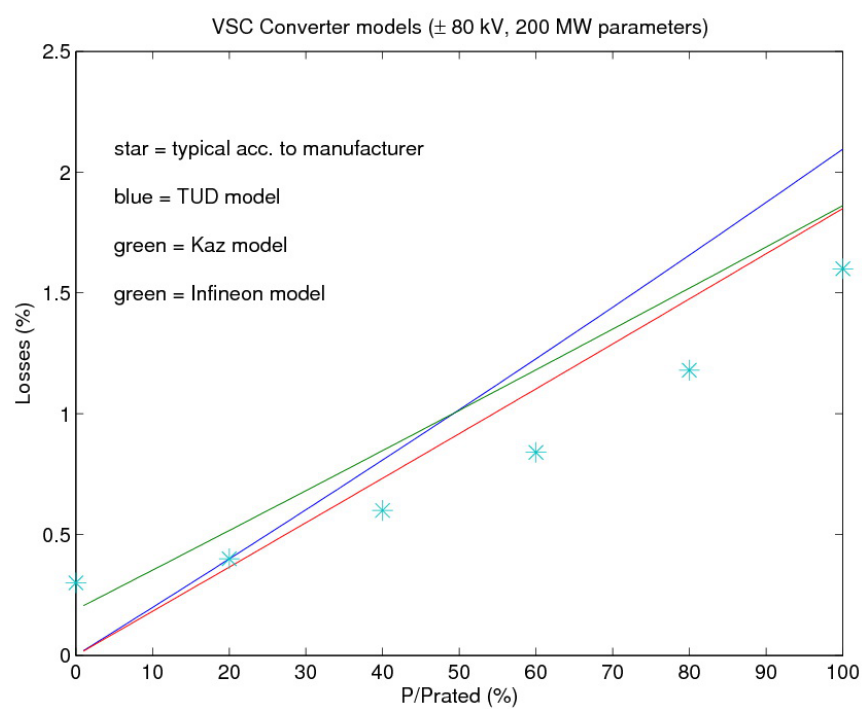
Figure 11 . PWM converter losses (divided by the rated power): Models compared to typical manufacture